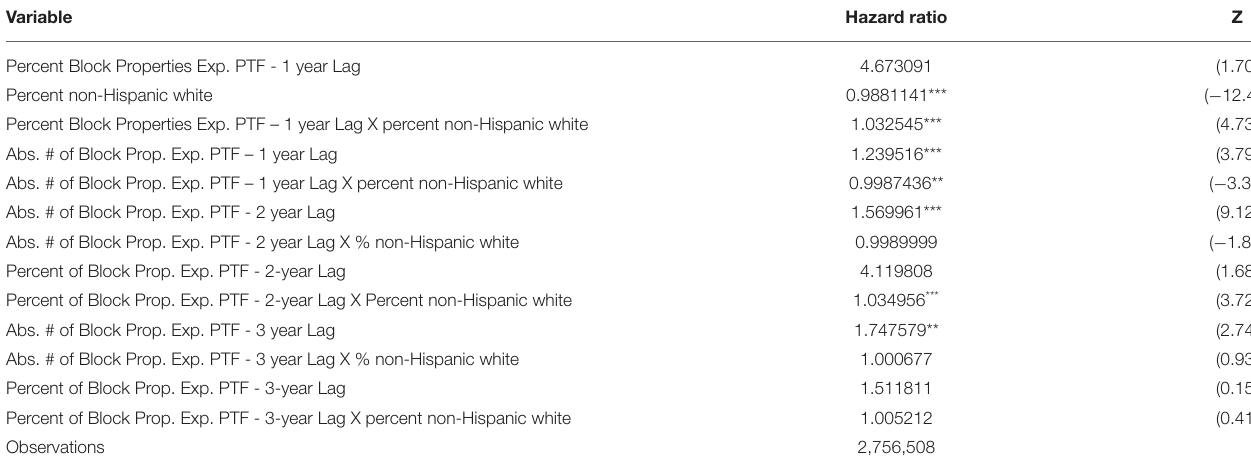
TABLE 5 | Cox model three.